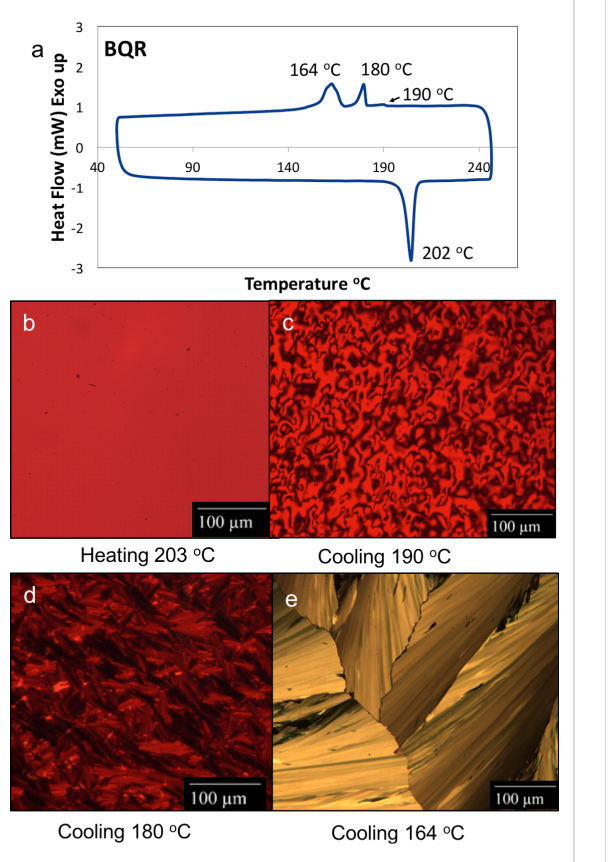
Figure 2: BQR thermal and POM properties. a) DSC thermogram of BQR under nitrogen at a ramp rate of 10 °C min –1 . b) BQR thin film sandwiched between two glass slides observed under a polarized optical microscope (POM) at 203 °C after heating. c) POM image of the same film when the stage temperature is lowered to 190 °C with distinct Schlieren texture for a NLC, d) POM image when the stage temperature is lowered to 180 °C, and e) POM image when the stage temperature is lowered to 164 °C where a distinct transmitted colour change is observed.